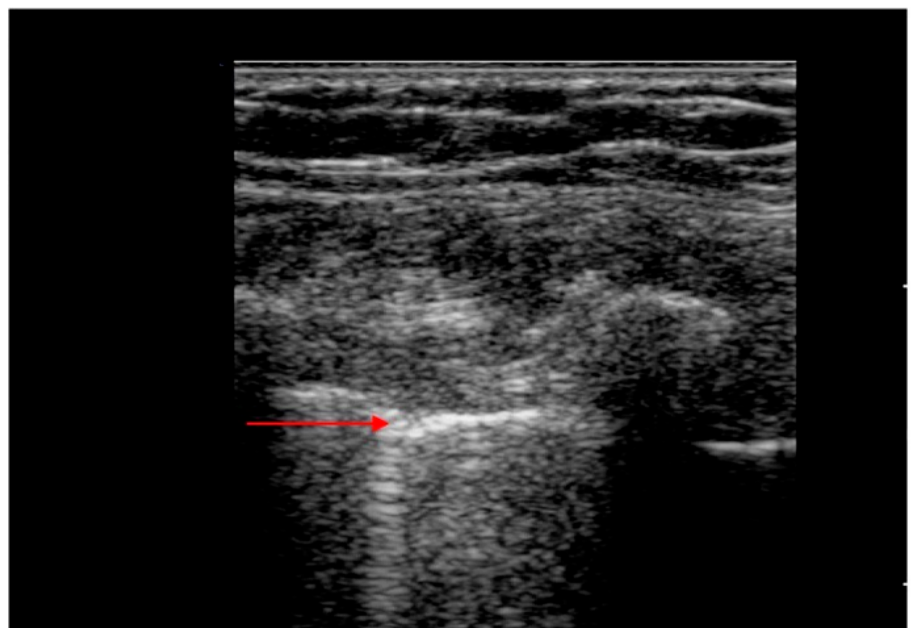
Figure 12. Thickened pleural lines in a COVID-19 patient. Thickened and irregular pleura (red arrow), suggestive of interstitial lung disease.